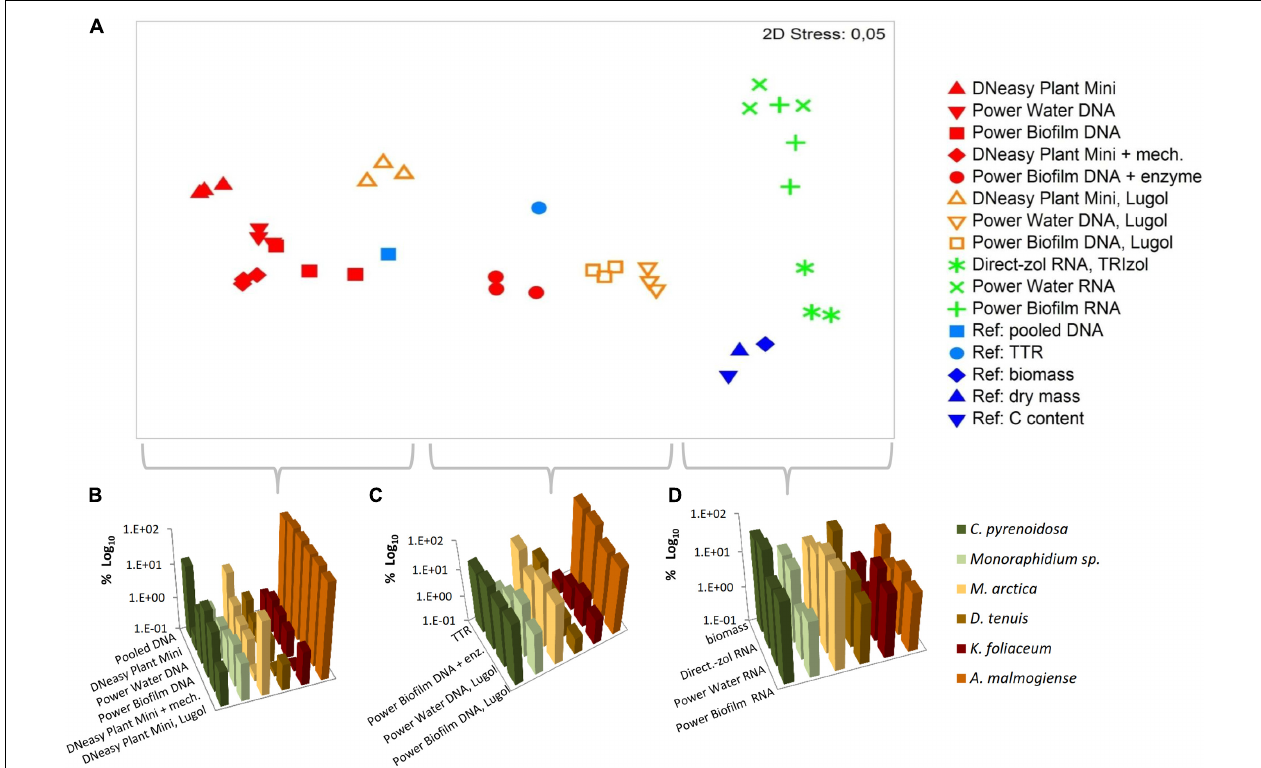
FIGURE 8 | Comparison of numerical relationships of mock species based on the NGS results and reference parameters. (A) Non-metric multidimensional scaling (NMDS) ordination of the data. (B–D) Illustration of the data in subsets separated by the NMDS ordination. TTR refers to theoretical template relationship. Note that the percentages in the y-axis are shown in logarithmic